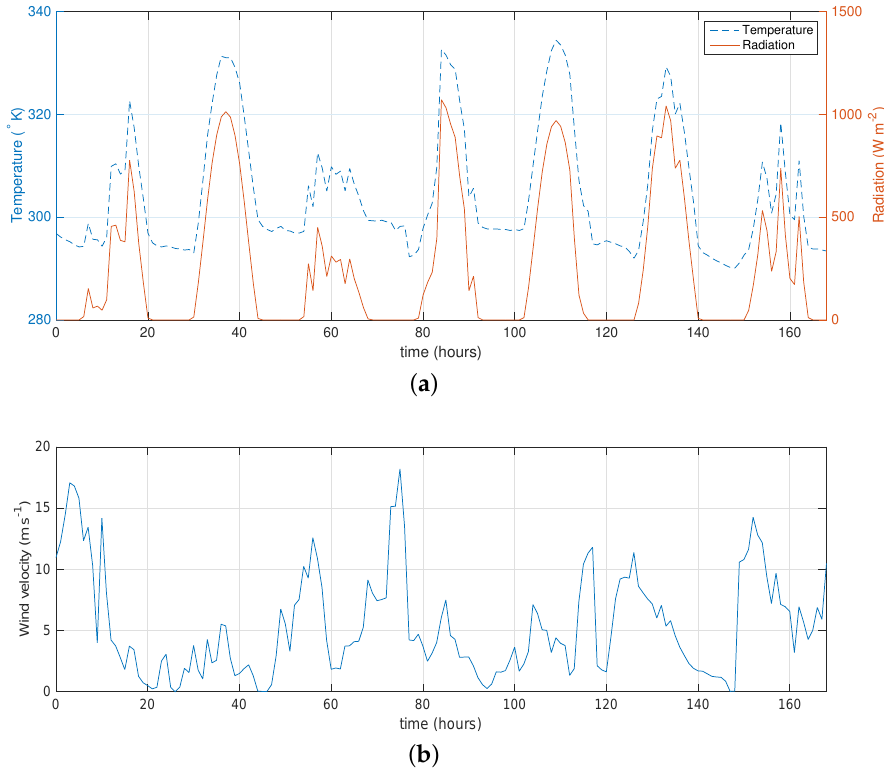
Figure 3. Weather variables’ profile of the first week of January 2011: ( a ) (dashed line) temperature and (solid line) radiation; ( b ) wind velocity.